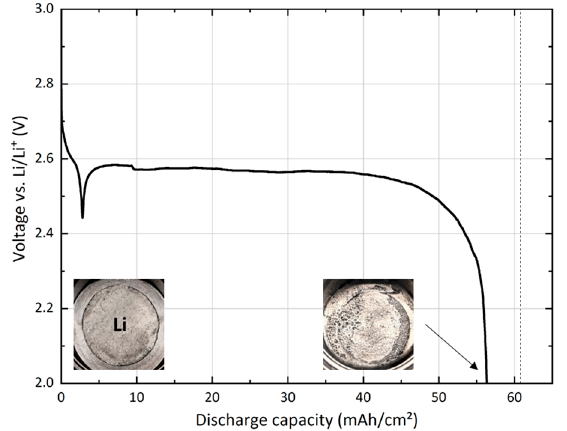
Figure 6. Discharge profile of a scaled-up cell using a stack of three GNS-loaded foam electrodes. The pictures in the graph depict the lithium anode before and after full discharge. The dashed vertical line marks the upper limit for the full consumption of the anode.